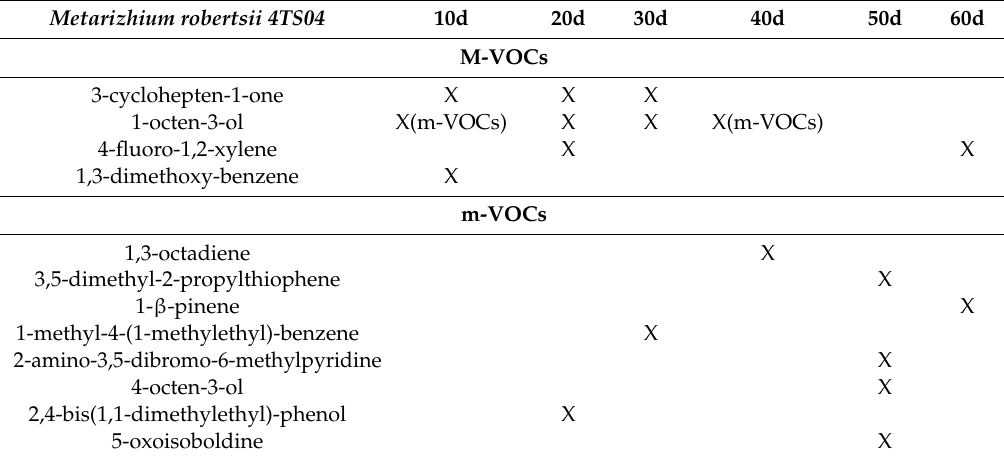
Table 4. M-VOCs and m-VOCs produced by M. robertsii 4TS04 during 60 days of growth. Abbreviations: VOC = volatile organic compound, M-VOCs = major VOCs, m-VOCs = minor VOCs, d = days after inoculation.